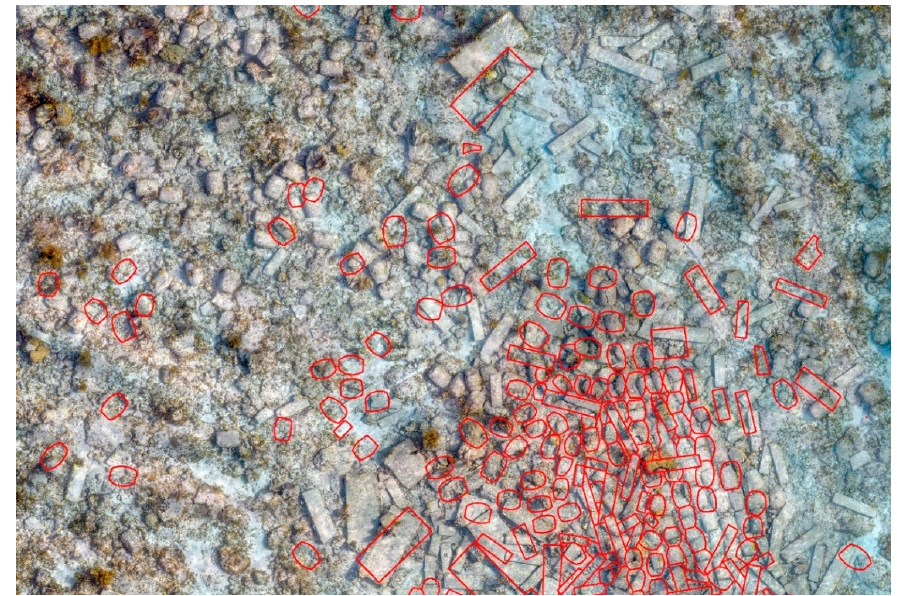
Figure 11. NPS hand drawn site plan from 1990 superimposed over the SfM model orthophoto.